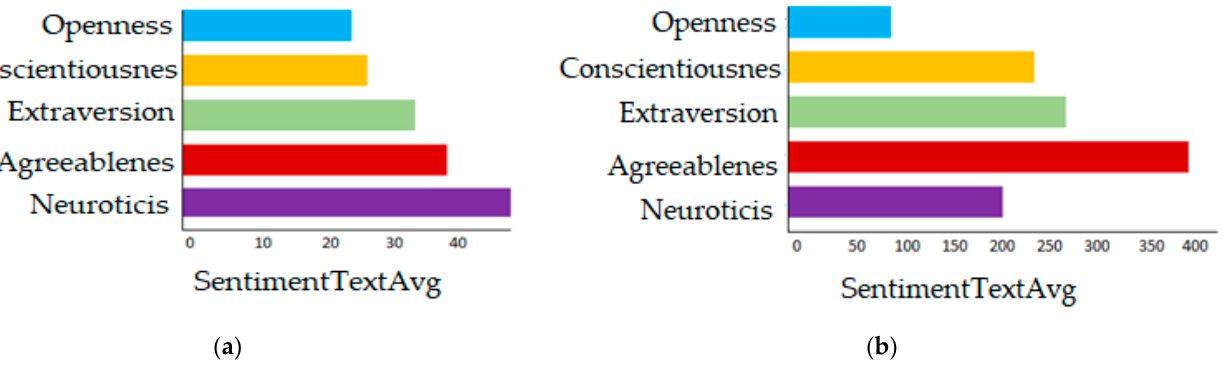
Figure 5. Identification of the number of followers by user personality trait.